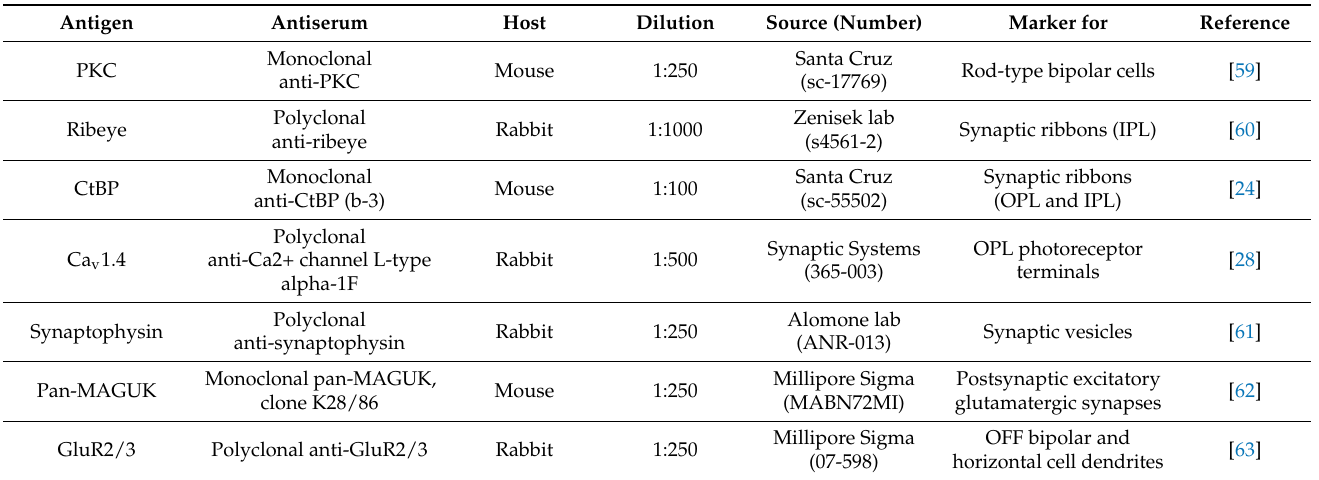
Table 1. Antibodies used in this